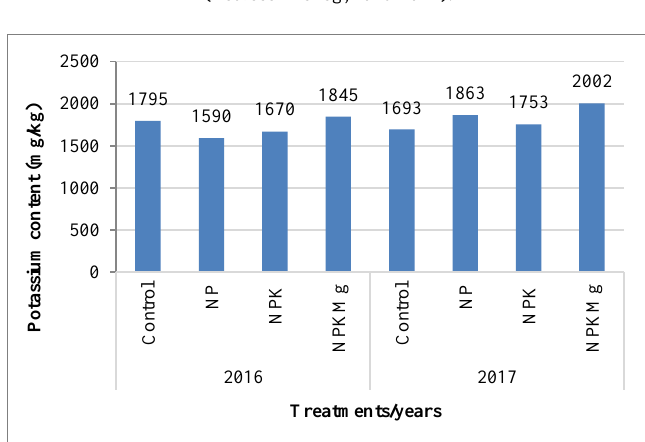
Figure 5 . Phosphorus and magnesium content of the fruits (Debrecen-Pallag, 2016-2017).